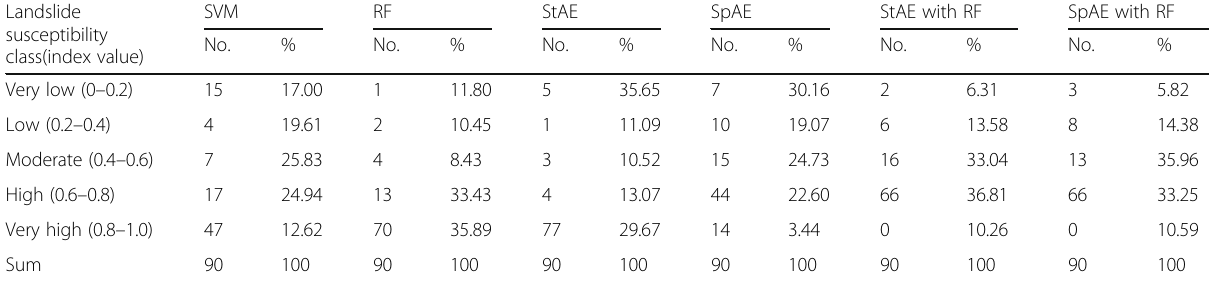
Table 4 Number of landslides occurred and percentage of landslide susceptibility class area Landslide susceptibility